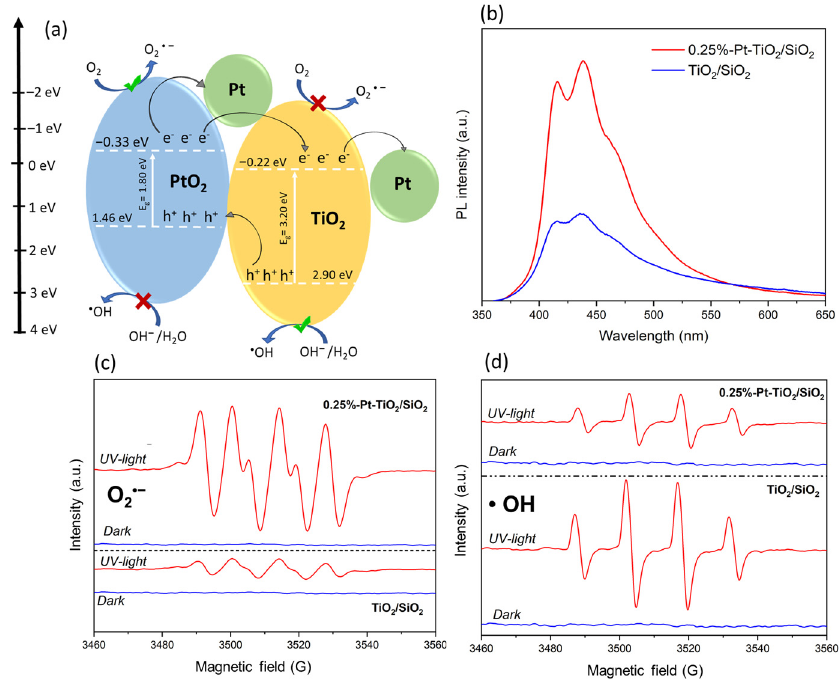
Figure 9. ( a ) Proposed photocatalytic mechanism; ( b ) PL spectra; ( c ) results of O 2 •− EPR measure- ments; ( d ) results of HO • EPR measurements.